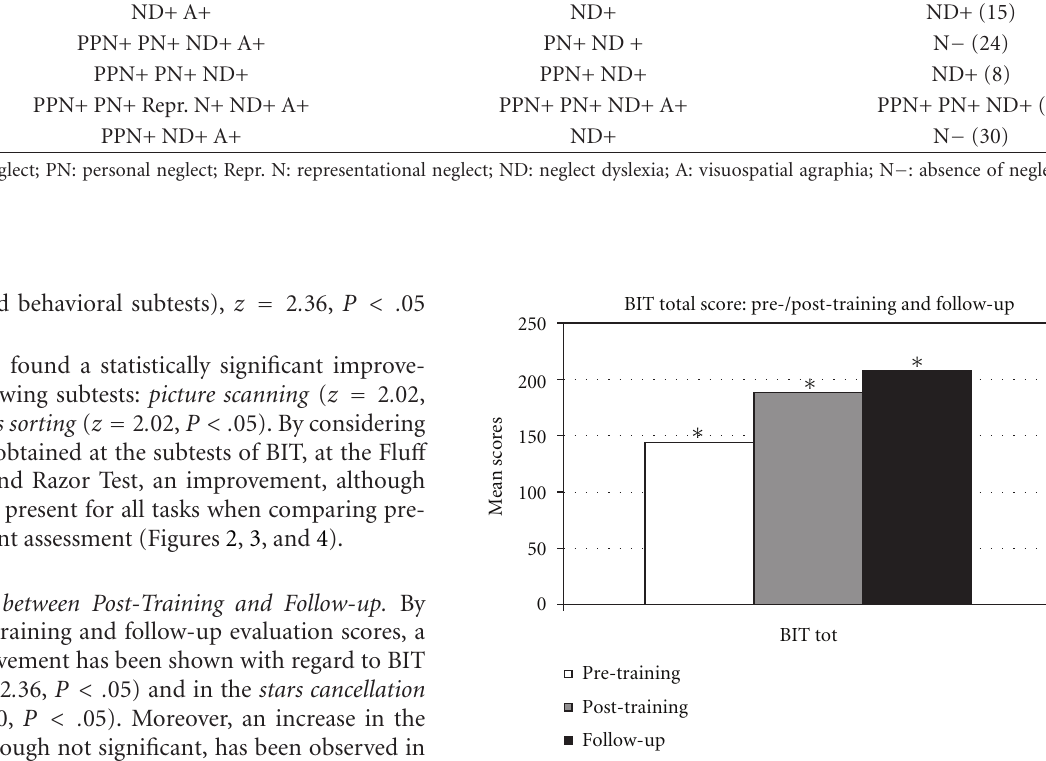
Figure 1: BIT total score in the pre-/post-training and in the follow- up evaluation. ∗ Significant